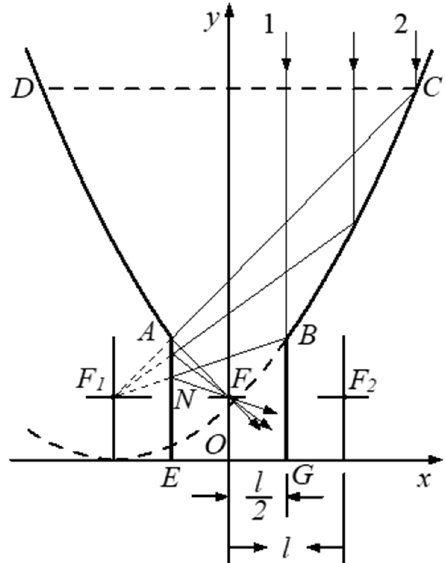
Figure A3. Diagram of light transmission in concentrator.